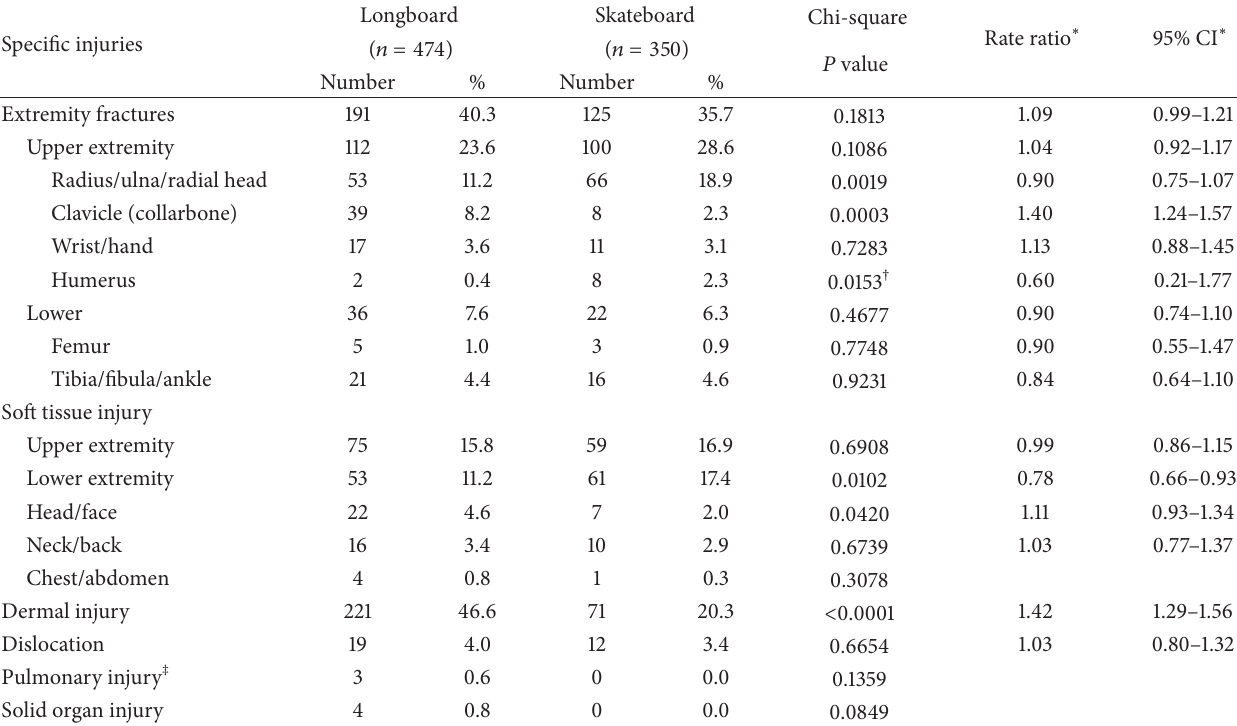
Table 2: Injury types according to longboard/skateboard